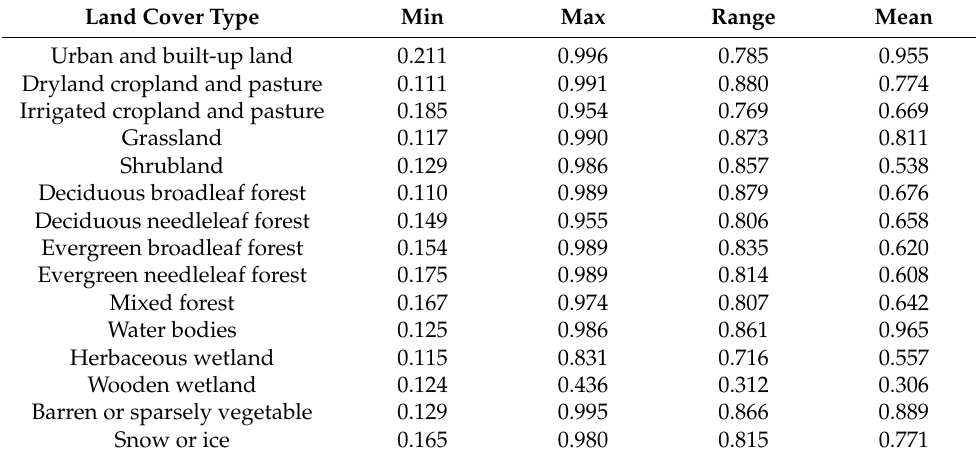
Table 6. Distribution of certainty values across land cover types.